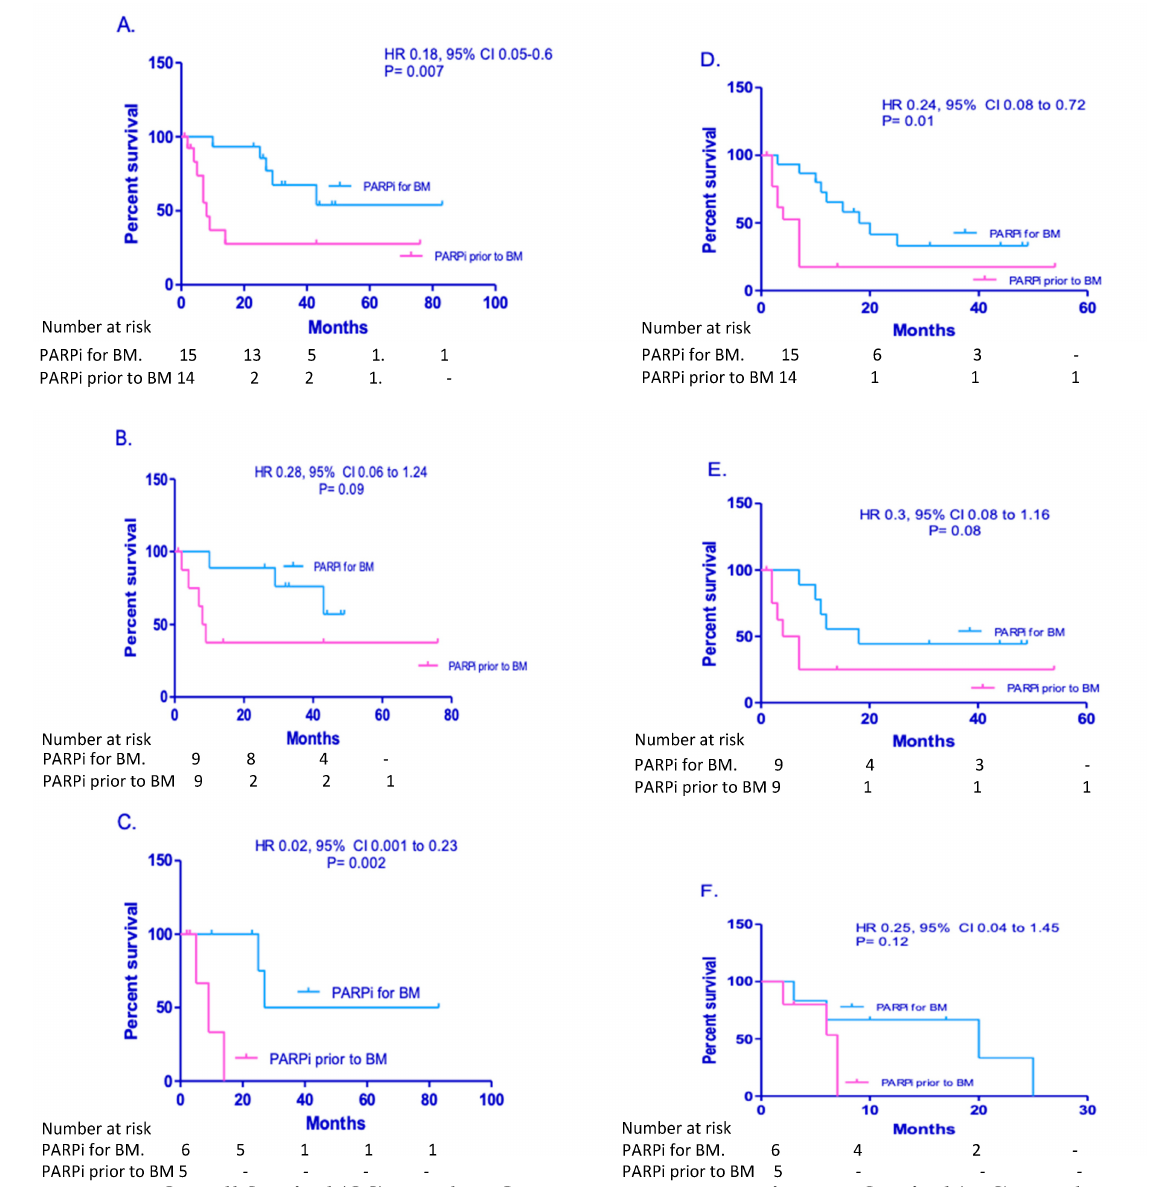
Figure 3. OS ( A – C ) and PFS ( D – F ) of EOC patients with BM according to PARPi for BM vs. PARPi prior to BM.